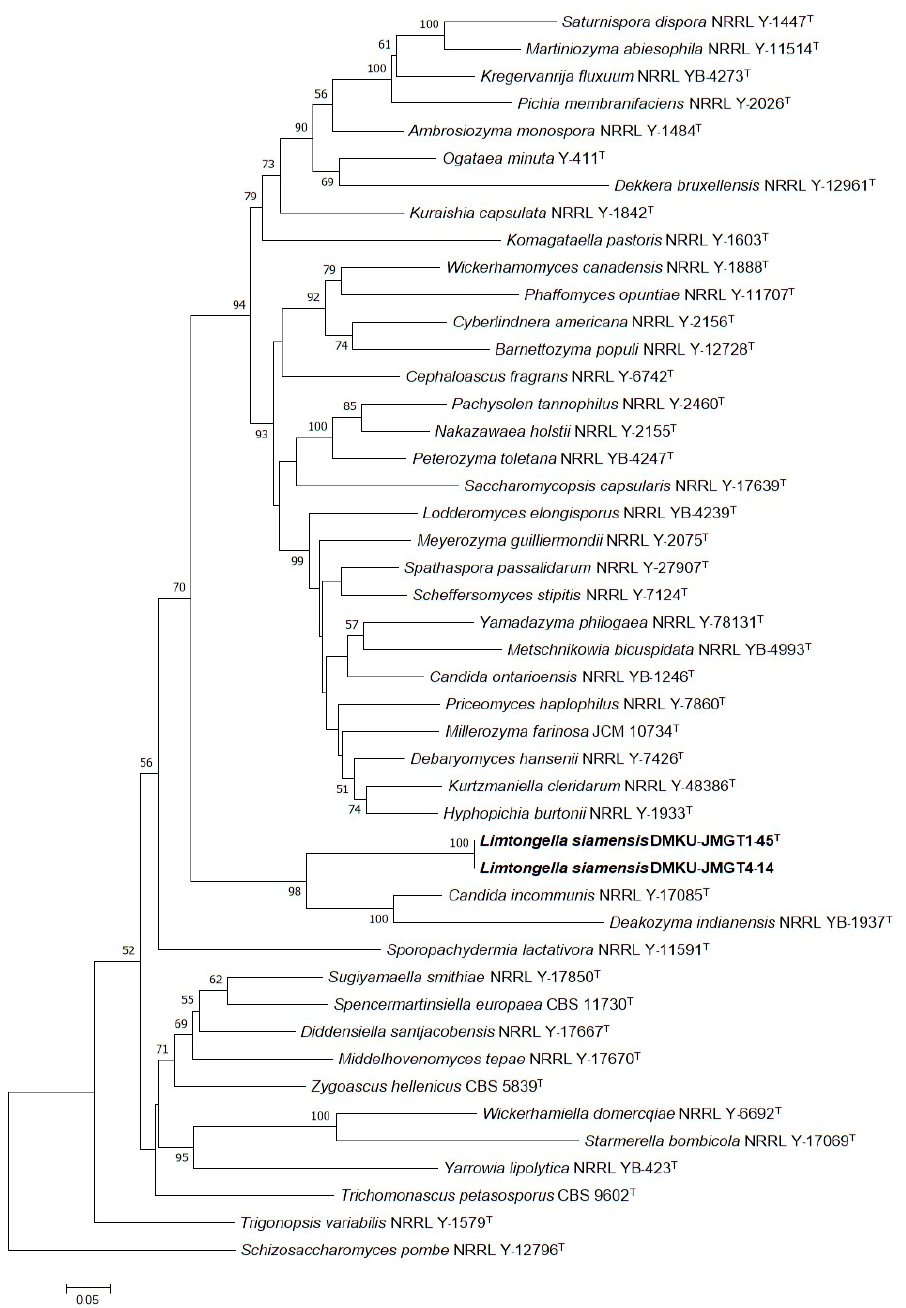
Figure 4. Phylogenetic tree based on maximum likelihood (GTR model) analysis of the small subunit rRNA (SSU), the D1/D2 domain of the large subunit (LSU) rRNA gene domain, elongation factor-1 α (EF-1 α ), RNA polymerase subunits 1 (RPB1) and 2 (RPB2) sequences showing the taxonomic placement of Limtongella siamensis DMKU-JMGT1-45 T and its sister species (both are shown in bold letters) within the family Trichomonasceae and related genera in the order Saccharomycetales. The percentage of replicate trees in which the associated taxa clustered together in the bootstrap test (1000 replicates) are shown next to the branches (50%). Schizosaccharomyces pombe CBS 356 T served as the outgroup species. T, type